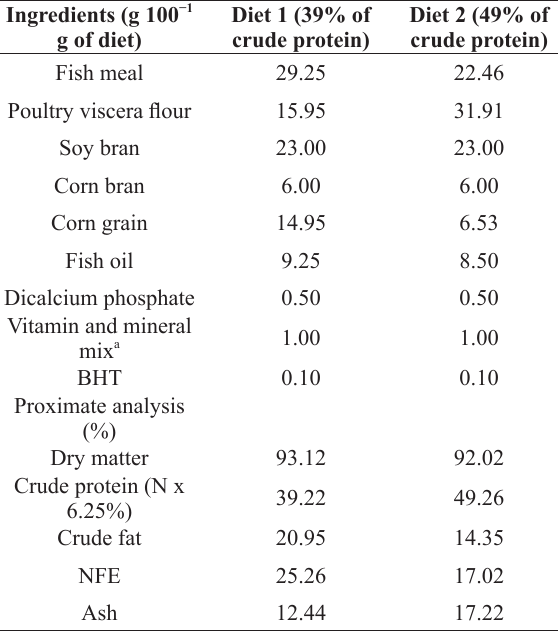
Composition of experimental